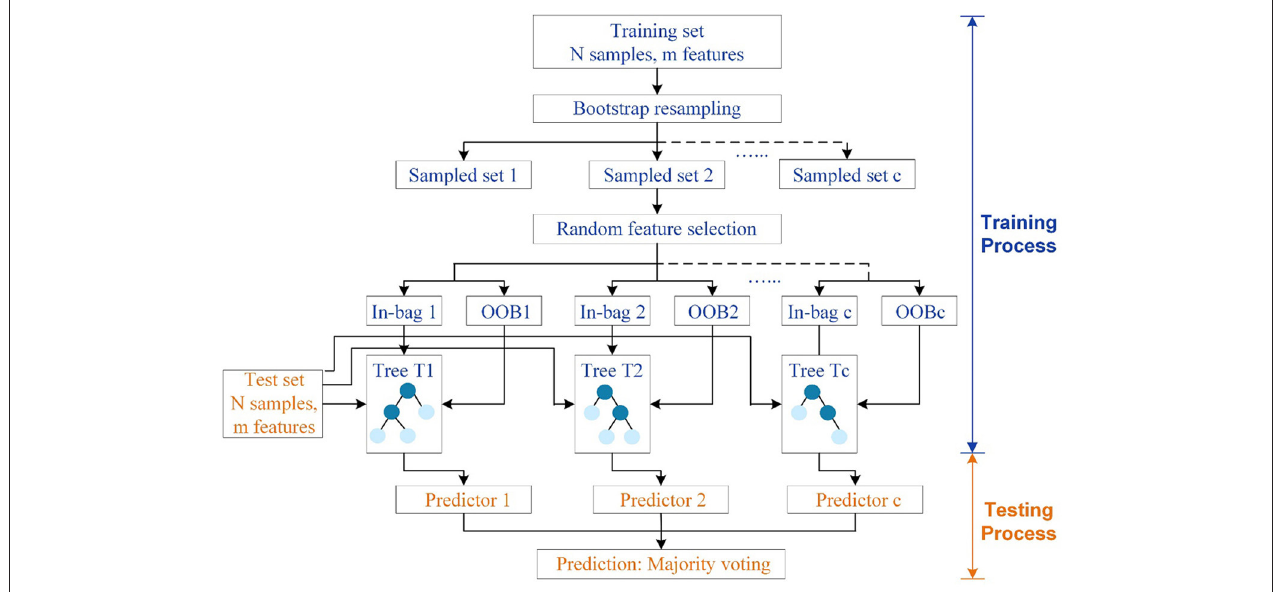
FIGURE 1 | Structure of RF. The training set and test set have N samples in m features. C independent trees are generated for model fitting. Circles in dark blue denote tree nodes except leaves, while circles in light blue represent terminal nodes or leaves.